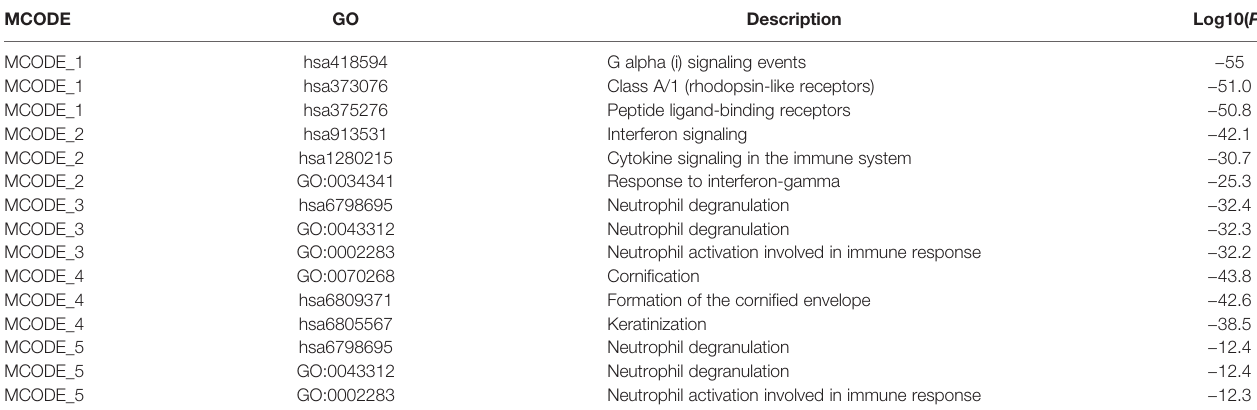
TABLE 2 | MCODE enrichment analysis in